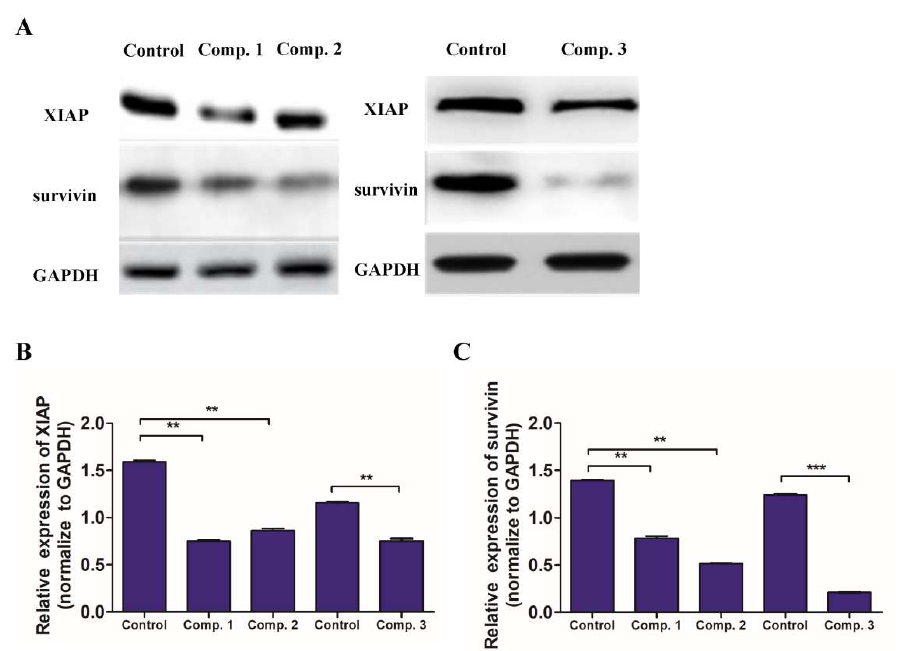
Figure 8. Effects of compounds 1 – 3 on expression of XIAP and survivin. A549 cells were treated with vehicle or the indicated compound for 24 h, and the relative levels of XIAP and survivin were determined by Western blot assays using GAPDH as a control. ( A ) Representative expression of XIAP and survivin. ( B ) Quantitative analysis of XIAP. ( C ) Quantitative analysis of survivin. Data are expressed as means from three independent experiments. ** p < 0.01, *** p < 0.001 vs. control group.